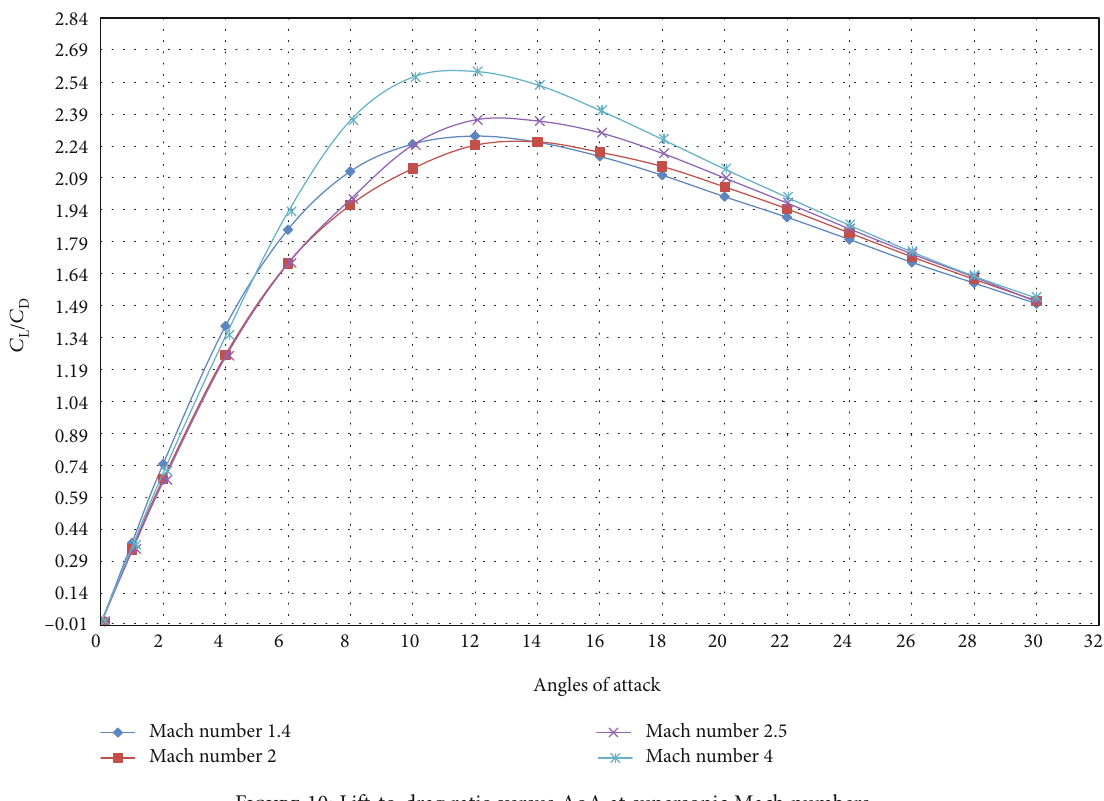
Figure 10: Lift-to-drag ratio versus AoA at supersonic Mach numbers.